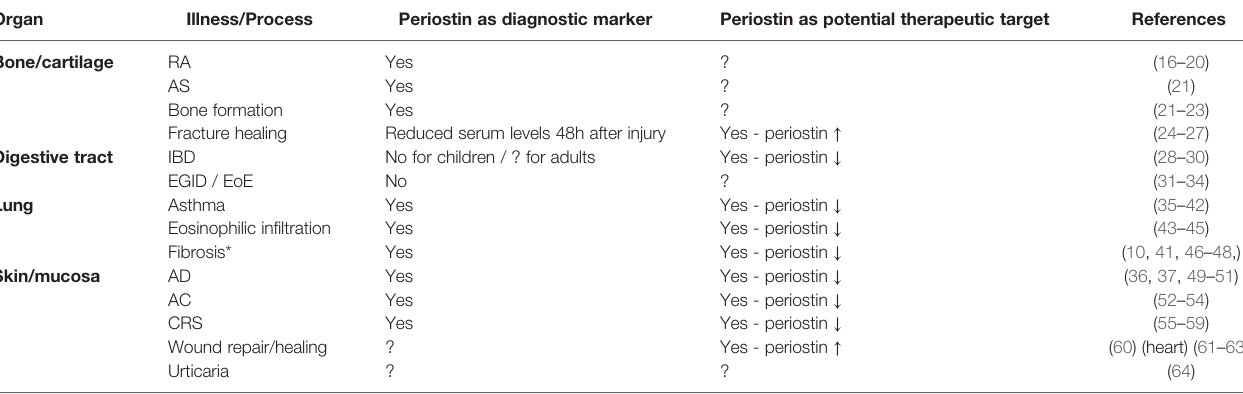
TABLE 1 | Periostin as a diagnostic marker and/or potential therapeutic target in different organs, illnesses and processes.